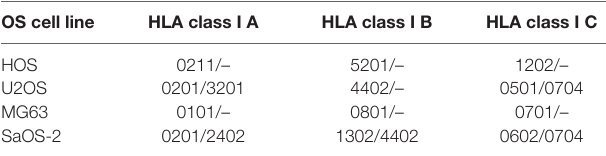
TABLe 2 | evaluations of γδ T cell therapy in OS. TABLe 1 | HLAs expression in the common human OS cell lines.